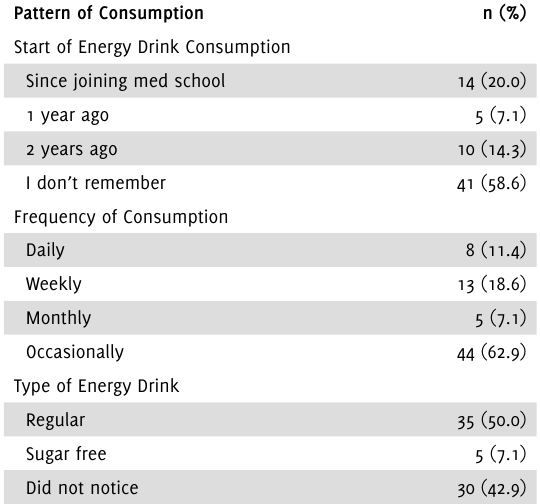
Table 2. Pattern of Consumption among Medical Students (N = 70).